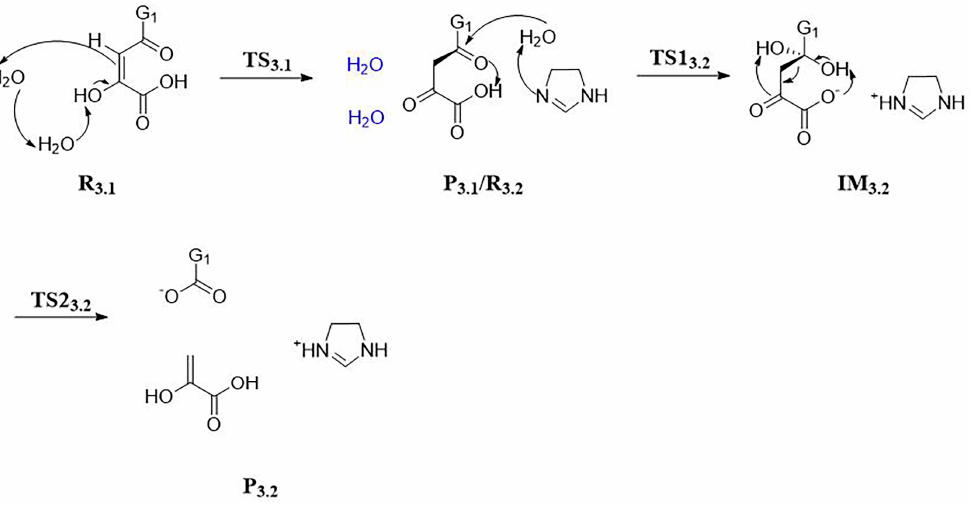
Figure 5. Under the calculated level of CAM-B3LYP/6 − 31+G**, the energy diagram of Stage 1.